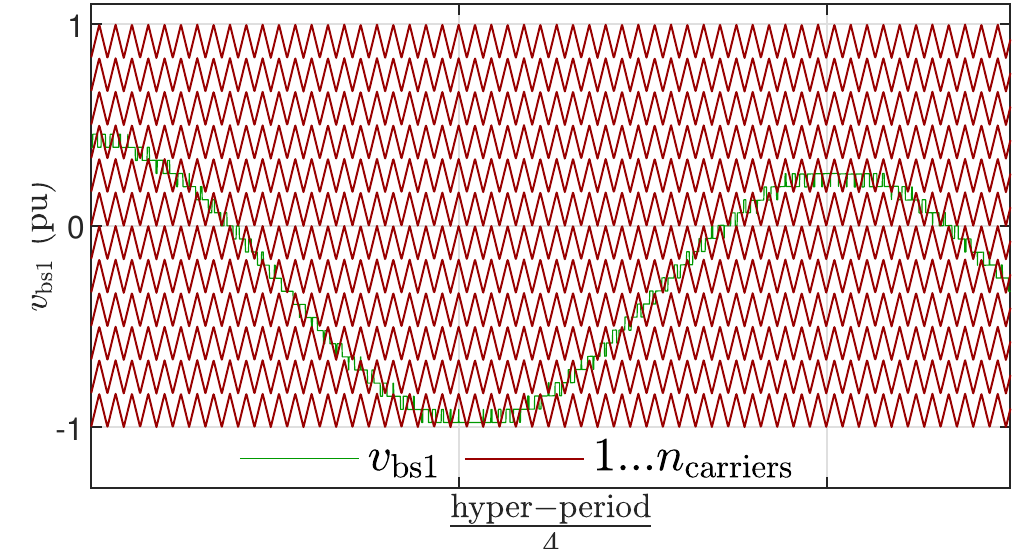
Figure 5. Twelfth PD–SPWM carriers and synthesized